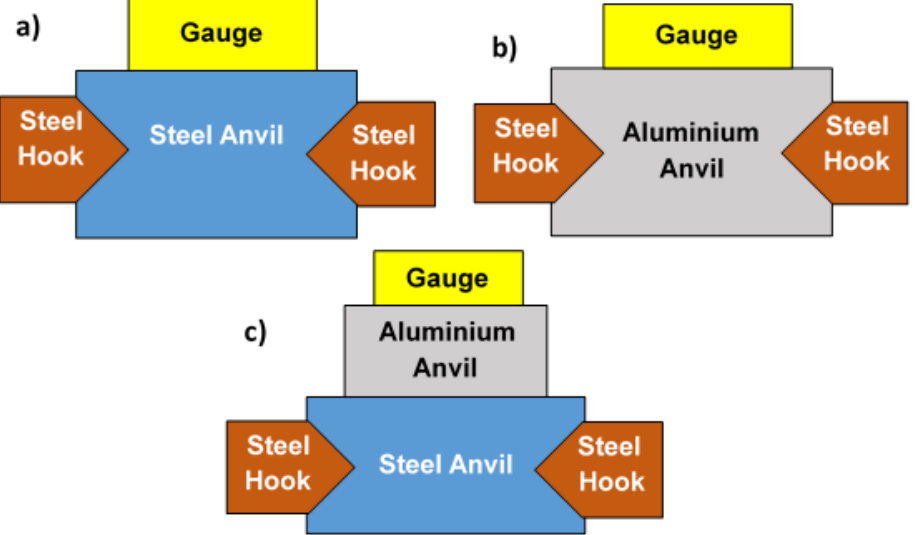
Figure 10. Variants of the setup: pressure sensor on steel anvil ( a ), pressure sensor on aluminium anvil attached with steel hooks ( b ), pressure sensor on aluminium anvil clamped over steel anvil ( c